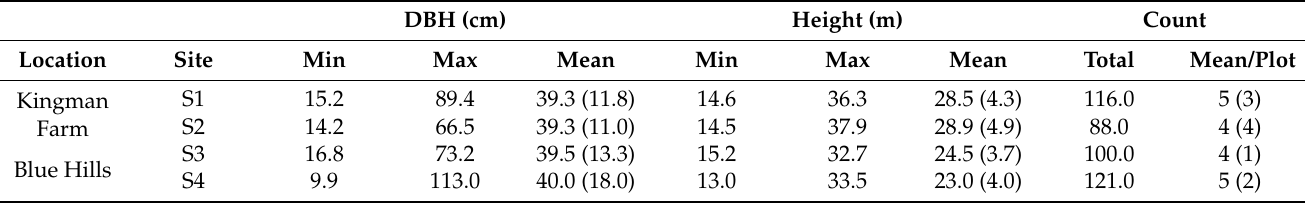
Table 4. Summary of ground data collection for all four sites. Standard deviation is given in parentheses for all means.